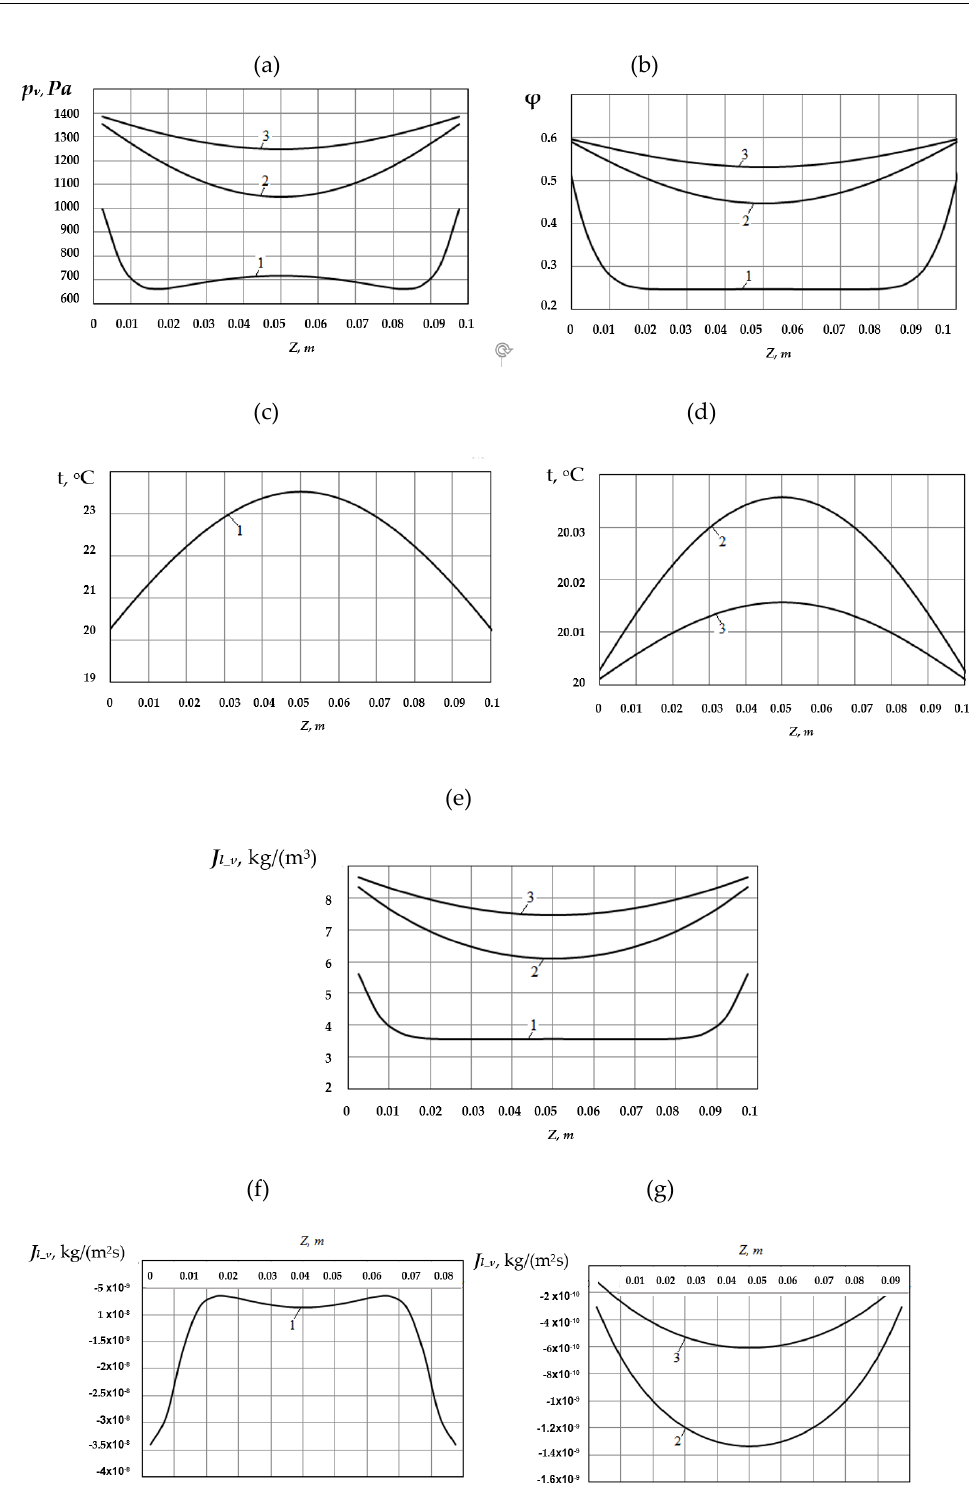
Figure 7. Distribution of the vapor partial pressure ( a ), relative air humidity ( b ), temperature ( c , d ), moisture content ( e ), and vapor flow density from the liquid column surfaces ( f ; g ) over the material thickness and moment of time: 1 – τ = 5×10 3 [s]; 2 – τ = 2.5×10 5 [s]; 3 – τ = 5.0×10 5 [s]. As seen from Figure 7a,b, as a result of moisture condensation on the surfaces and inside the material, the partial pressure of water vapor, as well as the relative humidity of